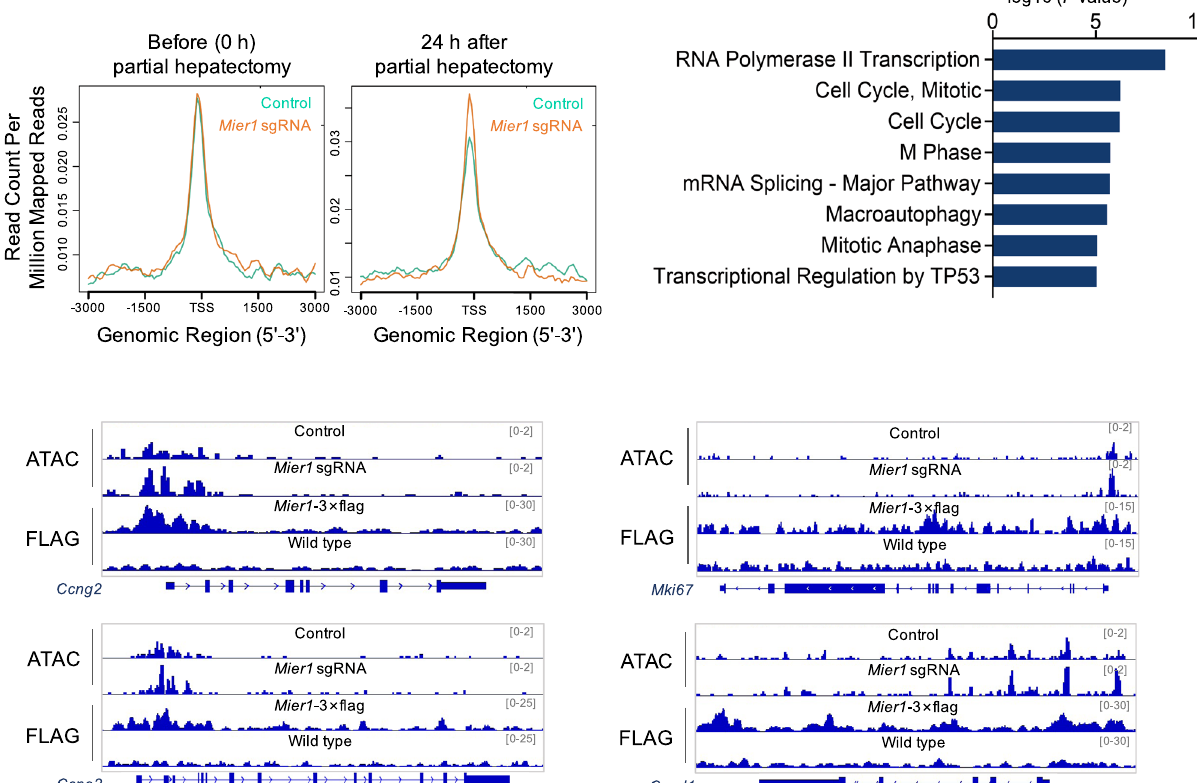
(above); Gene enrichment analysis of genes near these overlapped peaks (below). e Average intensity of ATAC-seq signals of the overlapped 2221 peaks as in ( d ) surroundingthetranscriptionstartsite(TSS)inControland Mier1 sgRNAgroupsat 24h post hepatectomy. f Liver ATAC-seq tracks and MIER1 signals near cell cycle- relevant genes at 24h after surgery in different groups as indicated. P values were assessed by two-tailed Fisher ’ s exact test ( b , c , e